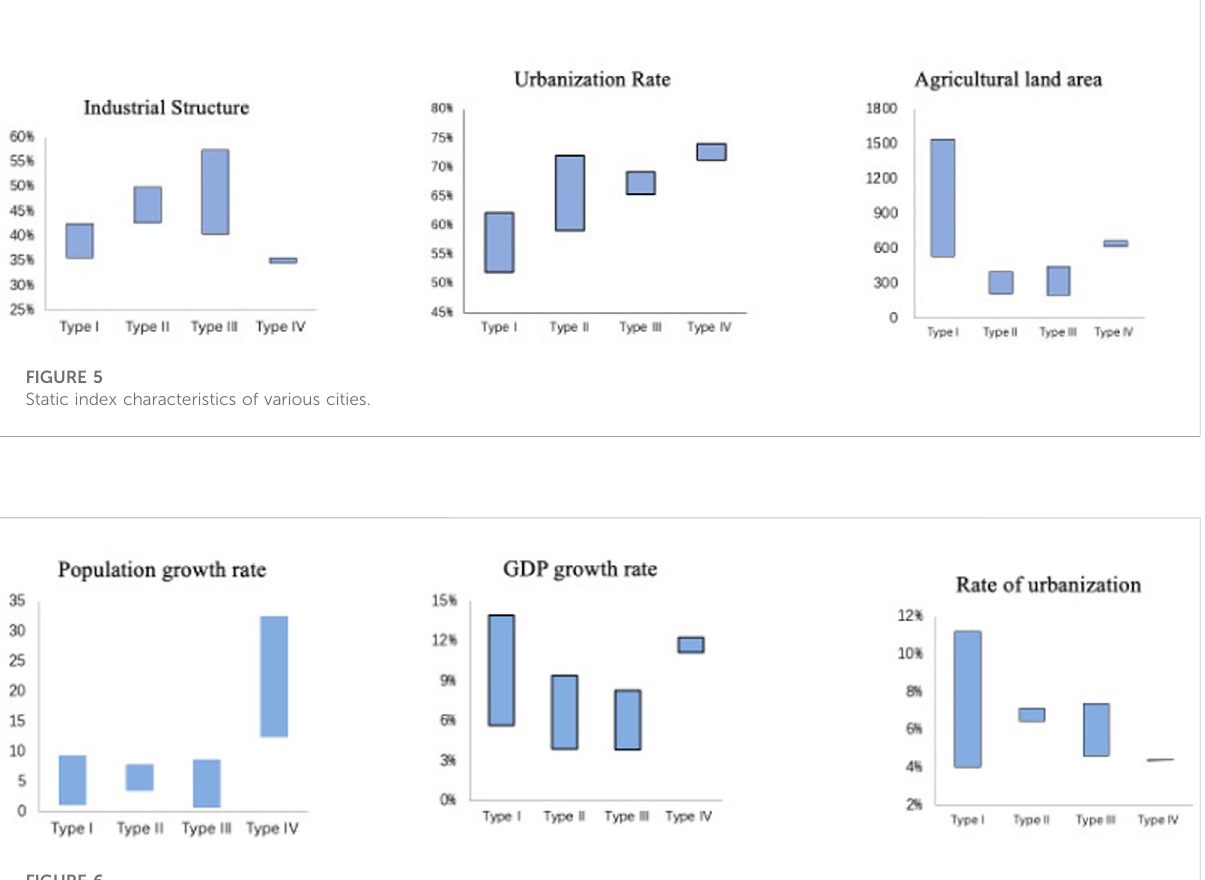
FIGURE 6 Dynamic index Characteristics of various